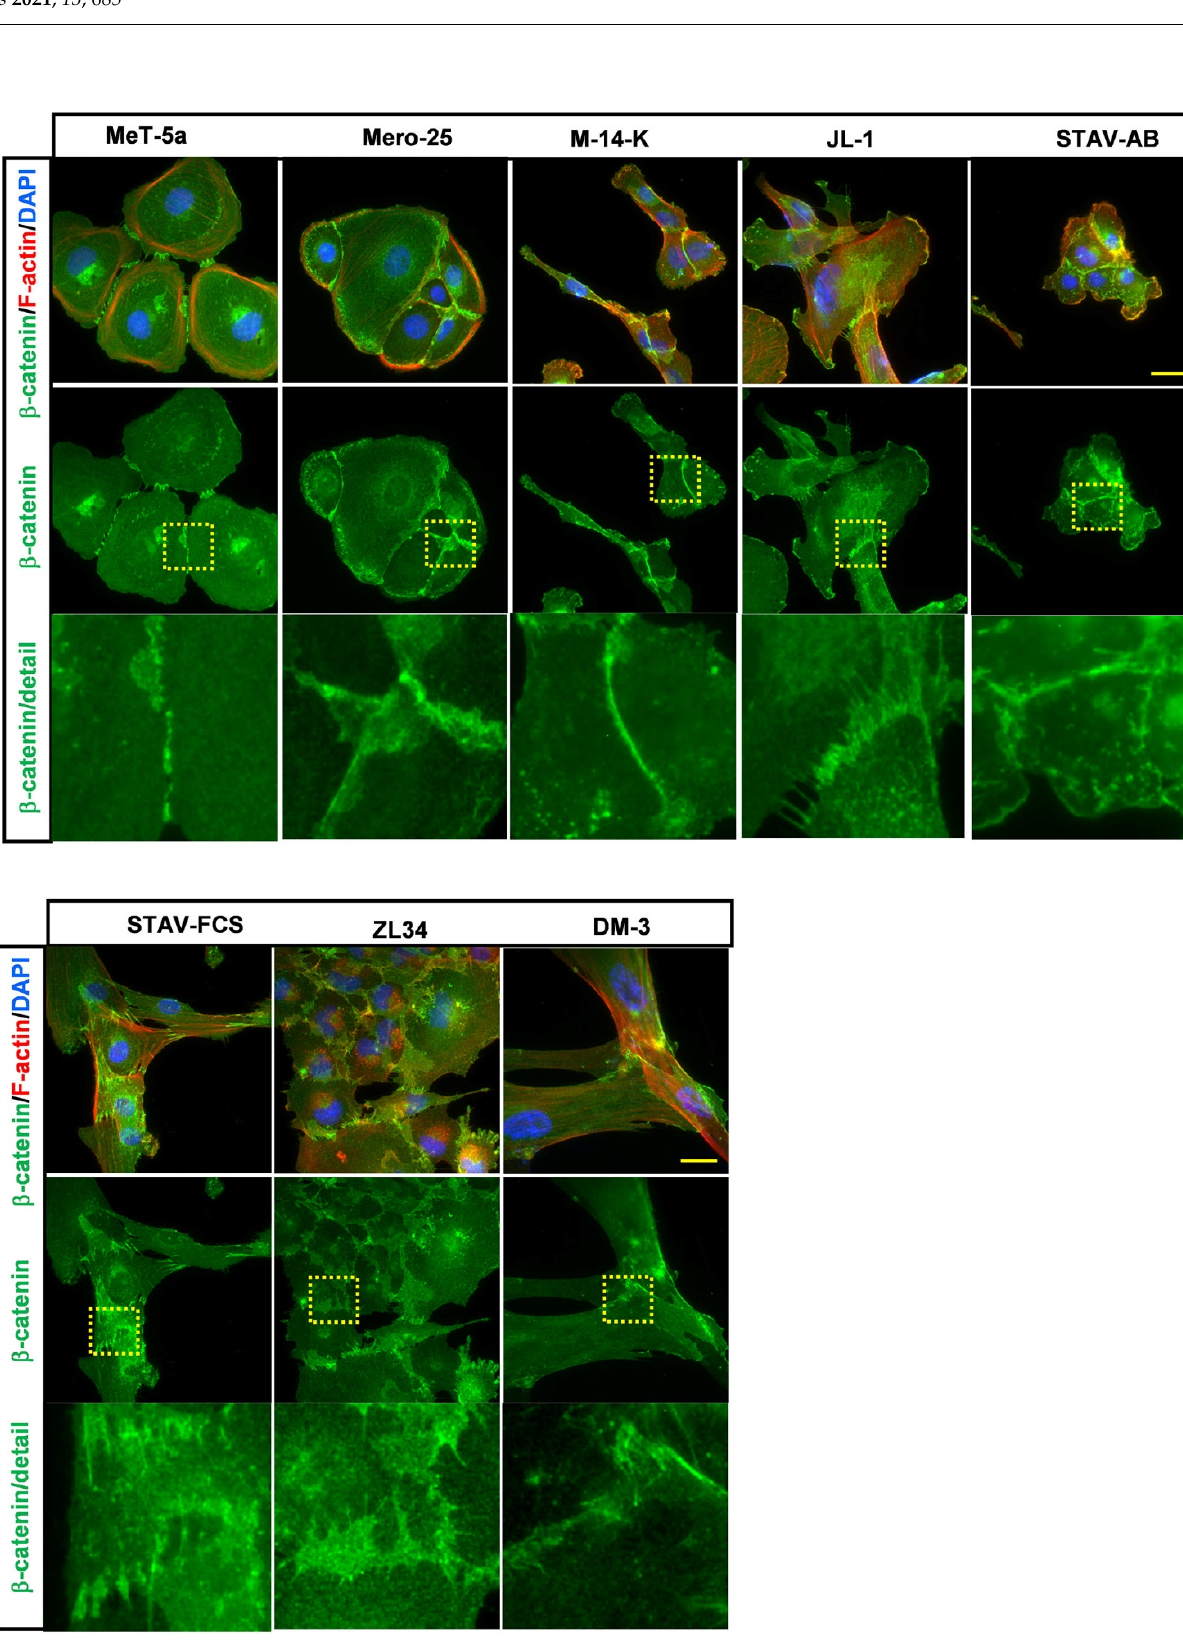
Figure 6. Organization of β -catenin. Representative images for the cell:cell contact areas visualized with a mouse anti– β - catenin antibody followed by an AlexaFluor488-conjugated anti-mouse antibody. Filamentous actin visualized with TRITC -conjugated phalloidin, Scale bar, 20 µm.